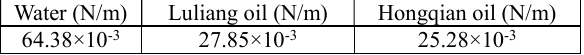
Table 2. Crude oil properties in the Hongqian oil area